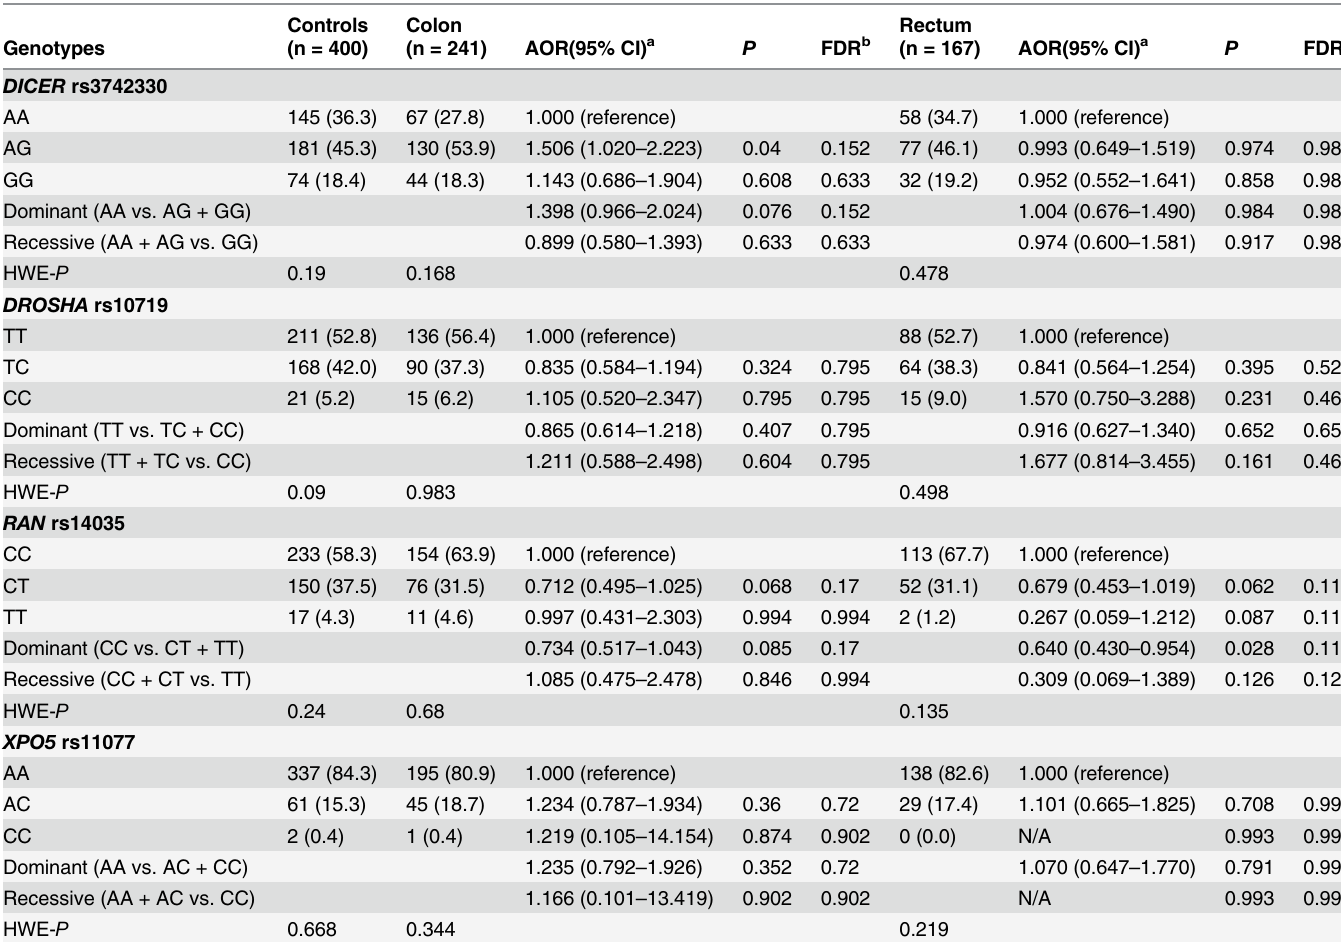
Table 3. miRNA machinery gene genotype frequencies and AORs in colon and rectal cancer cases and